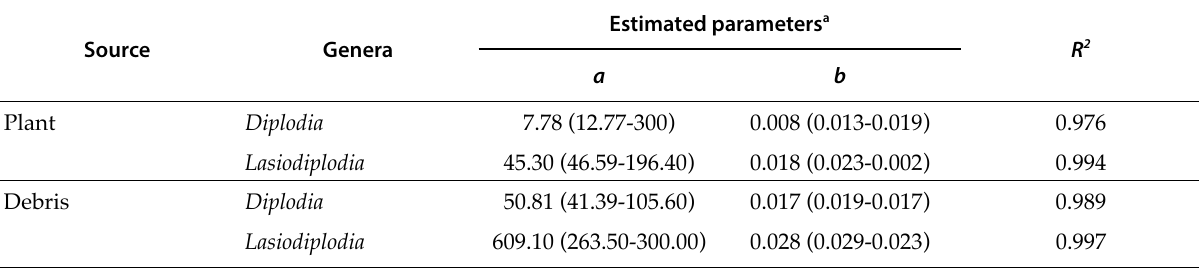
Table 1. Estimated parameters of logistic equations used to describe the proportions of seasonal Diplodia and Lasiodiplodia conidia (PSC) found over time from symptomatic plants or pruning debris in four vineyards in St Vicente Ferrer (Brazil),